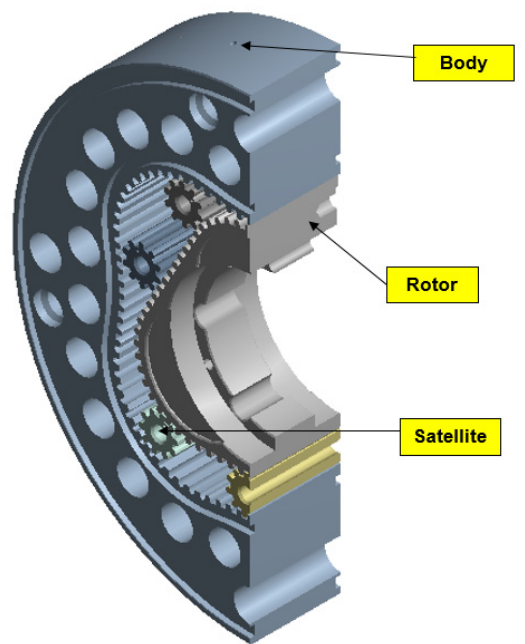
Figure 9. Elements of the M1 satellite motor where the temperature sensors were placed. During the experimental tests of the motor, the temperatures of the rotor and fixed elements were measured. The heating of the satellite was conducted in a specially made research system.